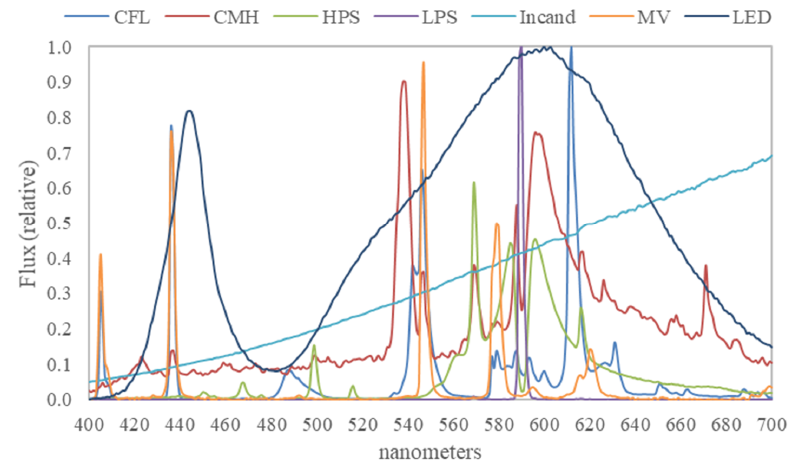
Figure 4. Spectral signatures of selected representatives of each lamp type used in the analysis. Note :